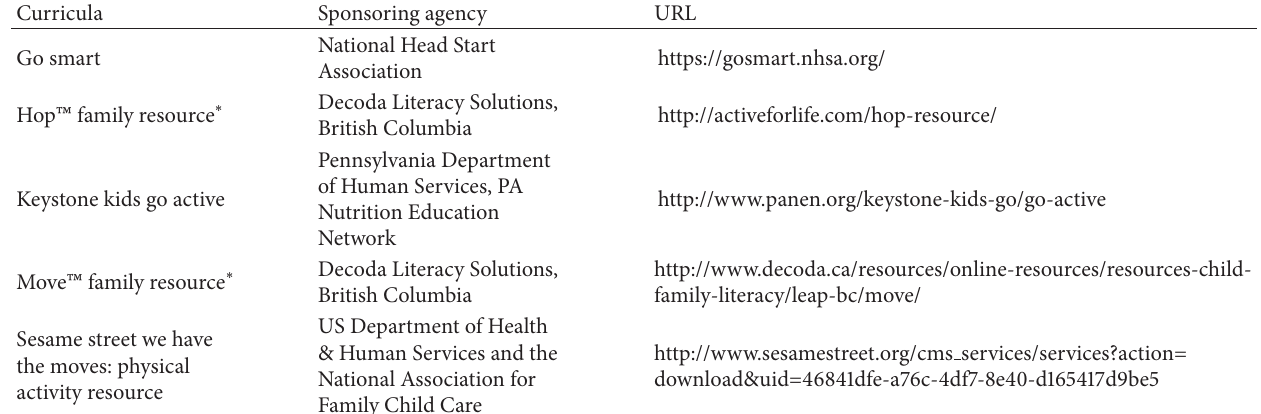
Table 1: Low-cost physical activity curricula accessible through the